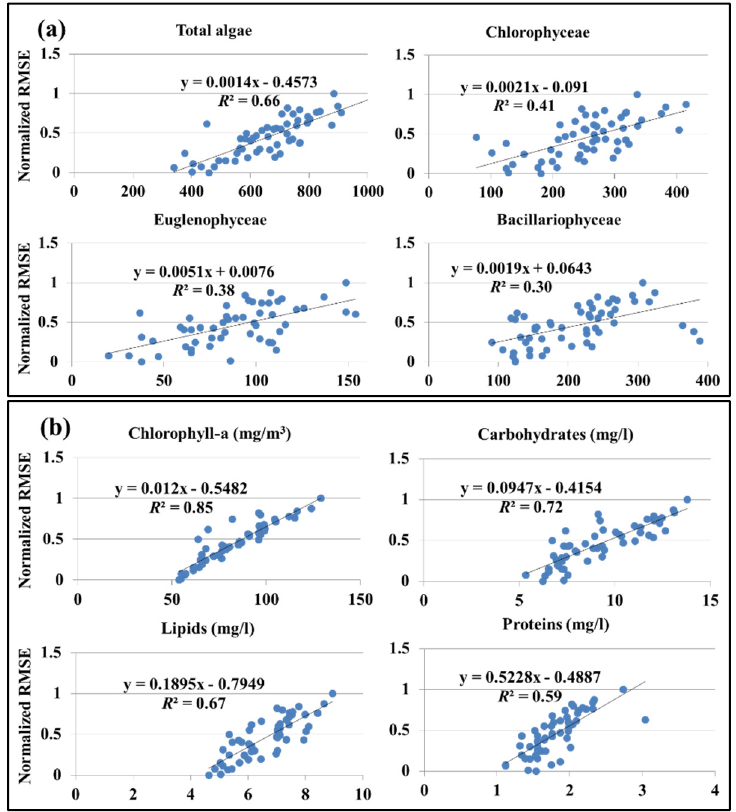
Figure 8. Regression analysis of the normalized RMSE against ( a ) algae contents (counts) and species, and ( b ) algae biological contents in Burullus Lake.